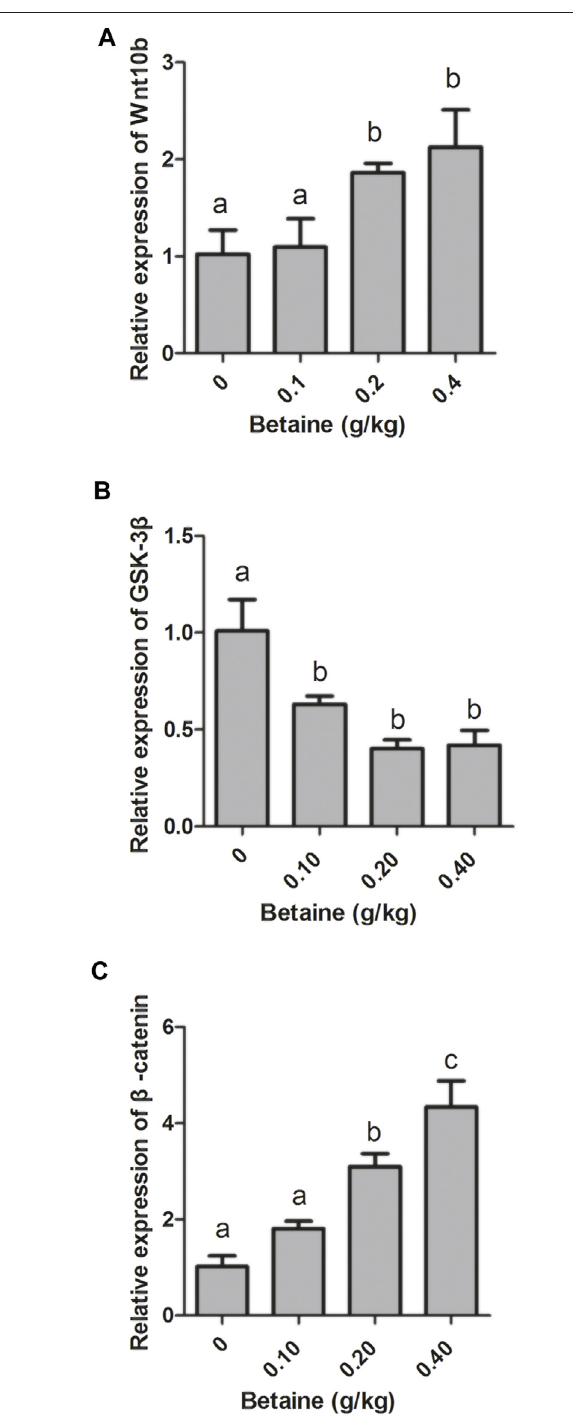
FIGURE2| EffectofbetaineonthemRNAexpressionofCAT,SOD,and GSH-PX in the liver of zebra fi sh. (A) The mRNA expression of CAT; (B) The mRNA expression of SOD; (C) The mRNA expression of GSH-PX. Values are expressedasmeans±sem( n =3).Statisticallysigni fi cantdifferencesare denoted by different letters ( p <